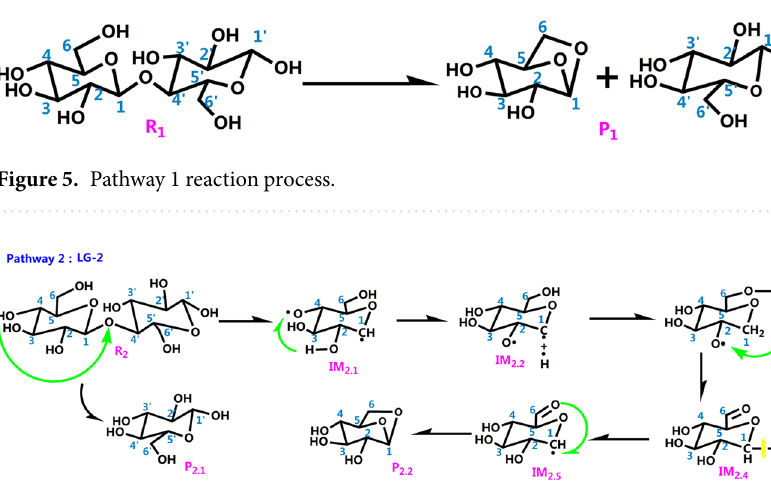
Figure 6. Pathway 2 reaction process.